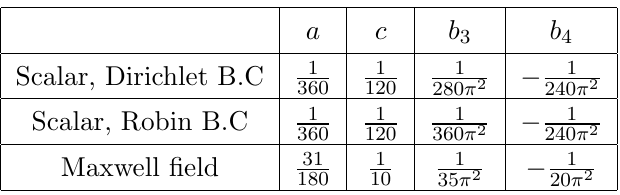
Table 1 . Casimir coe(cid:14)cients for 4d free BCFT.